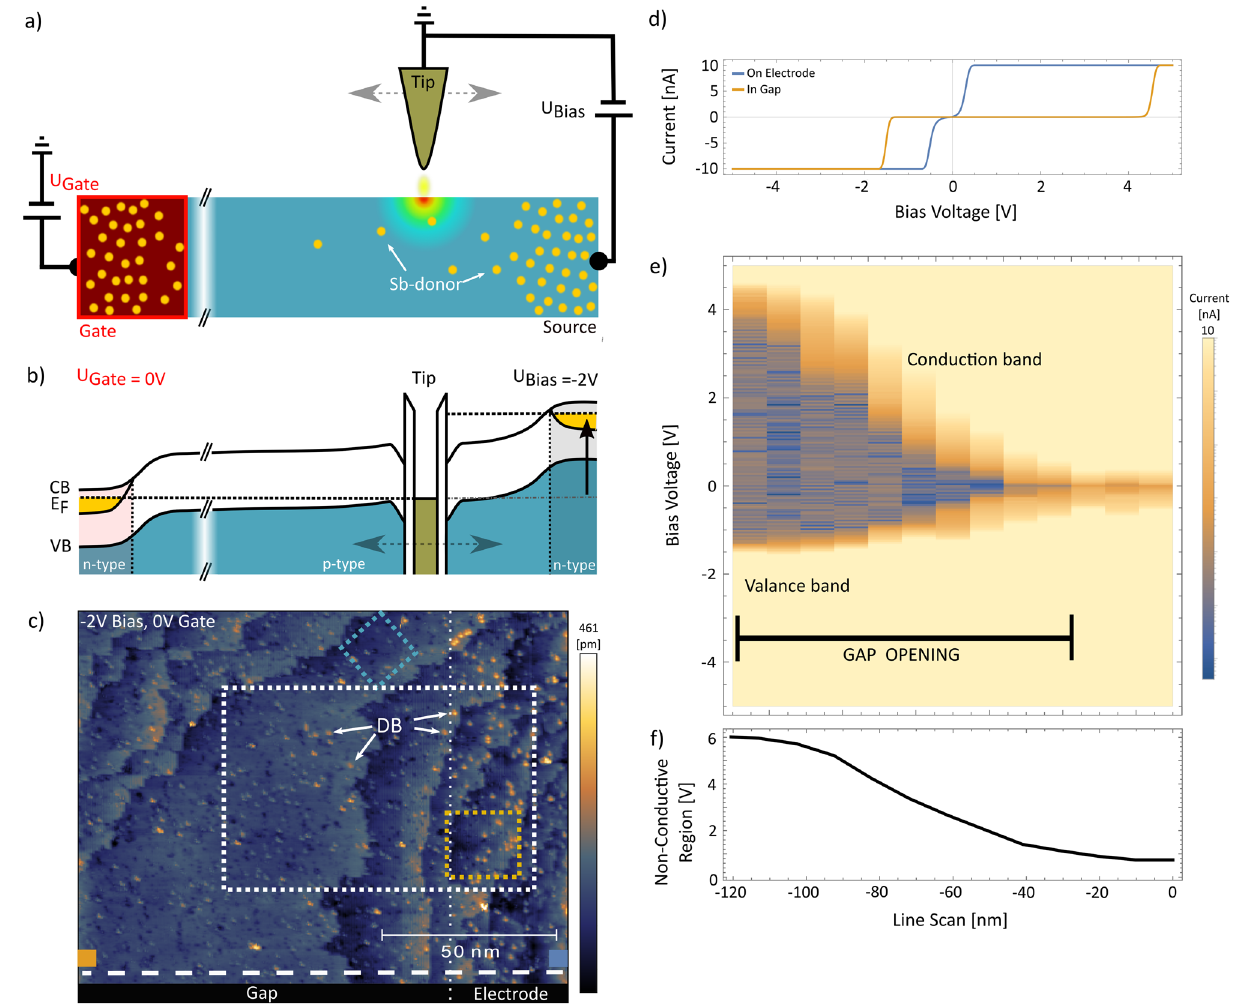
Figure 3. Electrical and topographic characteristics of tip-gap-electrode interface region without applied gate voltage: ( a ) schematic illustrating of the scanning tunneling spectroscopy method used to characterize the interface region. (b) Energy diagram of the npn-architecture at the Si-vacuum interface for an applied bias voltage of U Bias = − 2 V pointing out transport characteristics. E VB and E CB are the valance band and conduction band edges, respectively, while E F displays the level of the Fermi energy. The impurity band of the highly doped electrode region (yellow) resides in the band gap of silicon. ( c ) STM filled state image of the interface region. The change of dangling bonds (DBs) appearance indicates the doped source electrode region. Areas demarcated with blue, orange and white rectangles correspond to the location where STM topography images are acquired at different bias and gate voltages shown in Figs. 4b–d and 5a–c, respectively. ( d ) Two IV curves acquired on the conductive source region (blue curve) and within the insulating gap (orange curve; set-point current 100 pA, set-point voltage − 5 V, U Gate = 0 V, z-offset − 1.5 nm). The location of the IVs are indicated by coloured squares in ( c ) accordingly. ( e ) Log-Current map with the tip in contact (− 1.5 nm offset) to the surface reveals a ∼ 100 nm transition from metallic to insulating at the electrode-gap interface. The spectroscopy data is acquired along the dashed line highlighted in ( c ). ( f ) Plot of the non-conductive region (extracted from current map in ( e )) as a function of distance to the source electrode (current cut off 300 regions appears in the IV spectra when gradually moving the SPM tip further apart from the bias electrode (see also Fig. 3f) in which the non-conducting gap increases up to ∼ 6 V (current cut off 300 pA). The most obvious explanation for a rather smooth transition from metallic to insulating rather than a sharp cut off is the pres- ence of out diffused donor or stray dopants in the p-type doped gap region that migrated from the implanted electrode regions during RTAs. In this case we expect the stray donor density to be dependent on the distance to the source electrode. The energy diagram of our npn-architecture including the SPM tip is depicted in Fig. 3b. In equilibrium (left side of Fig. 3b) the Fermi energy level of the electrodes (highly doped n-type silicon) resides close to the conduction band (CB) level while for the Si host (low-doped p-type silicon) it locates close to the valence band (VB) level. In equilibrium both Fermi levels align resulting in an increased contact potential barrier formation between both regions, typical for a pn-junction. On the right side of Fig. 3b a low negative voltage is applied to